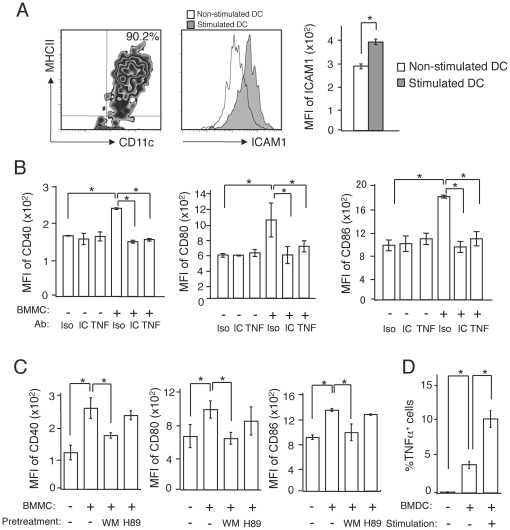
DC stimulation depends on ICAM-1-LFA-1 signals and membrane-bound TNF-α on MCs.(A) The expression of ICAM-1 on stimulated or non-stimulated BMDCs. (B, C) The expression levels of CD40, CD80, and CD86 on BMDCs co-cultured with BMMCs with isotype control Ab (Iso), anti-ICAM-1 Ab (IC), or anti-TNF-α Ab (TNF) (B), or co-cultured with BMMCs that were pretreated with or without wortmannin (WM) or H89 (C). (D) BMMCs expressing membrane-bound TNF-α in the presence of absence of BMDCs with or without stimulation with 100 ng/ml of LPS and 50 ng/ml of CCL21 for 1 h. All data are presented as the mean ± SD and are representative of three experiments. *, P<0.05.